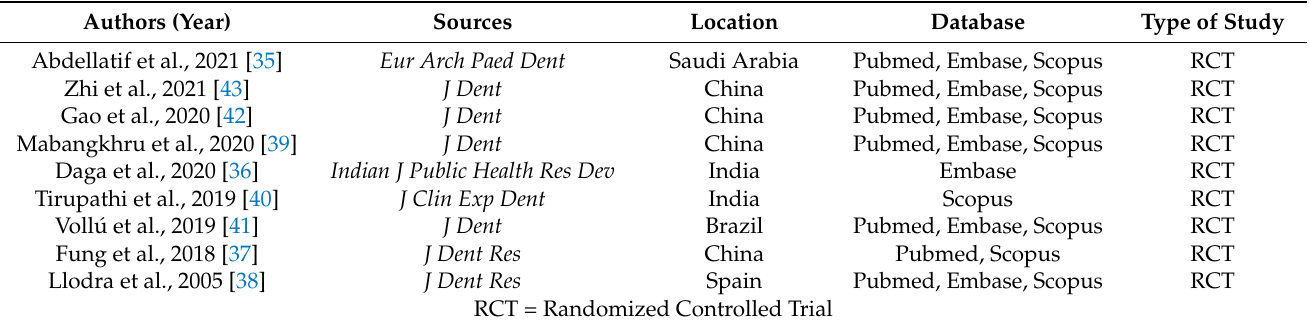
Table 1. General characteristics of the included studies regarding the efficacy of SDF in arresting caries lesions in primary